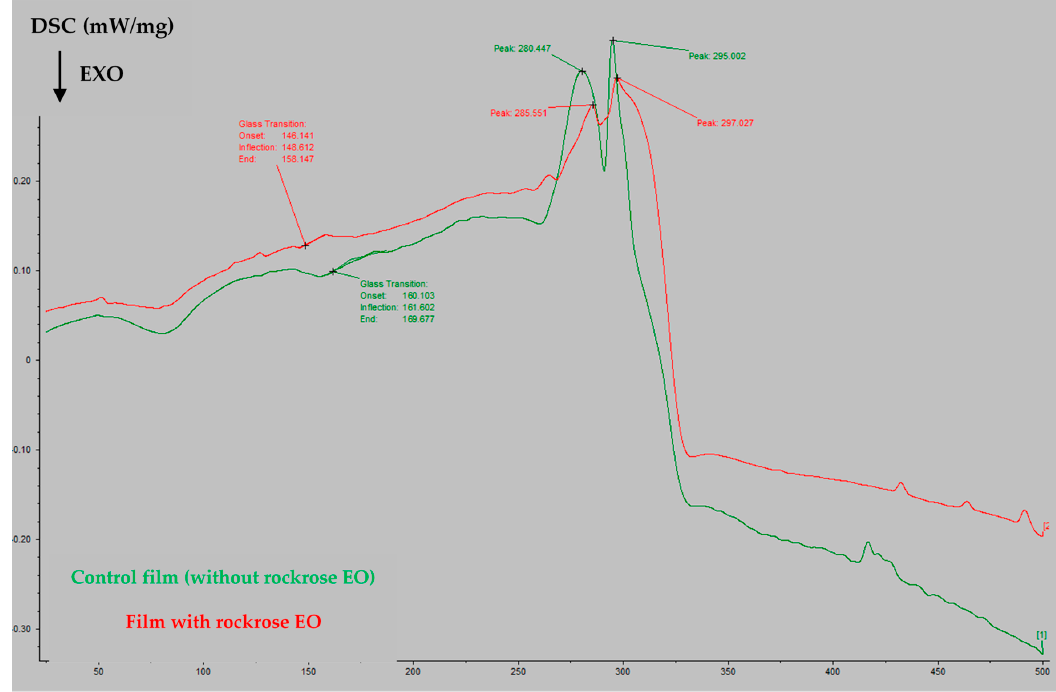
Figure 2. DSC thermograms of the pullulan-based films.